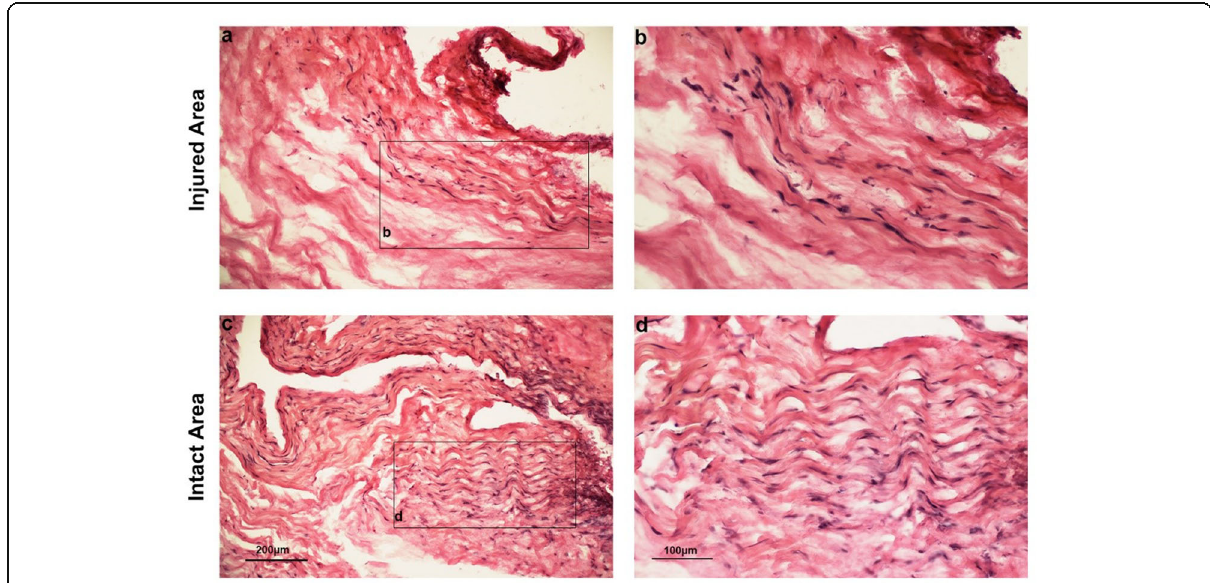
Fig. 6 Photomicrographs of the injured and intact Achilles tendon stained with haematoxylin and eosin ( a-d ). All images are representatives from 5 patients. Original magnification is 10x ( a and c ) or 20X ( b and d